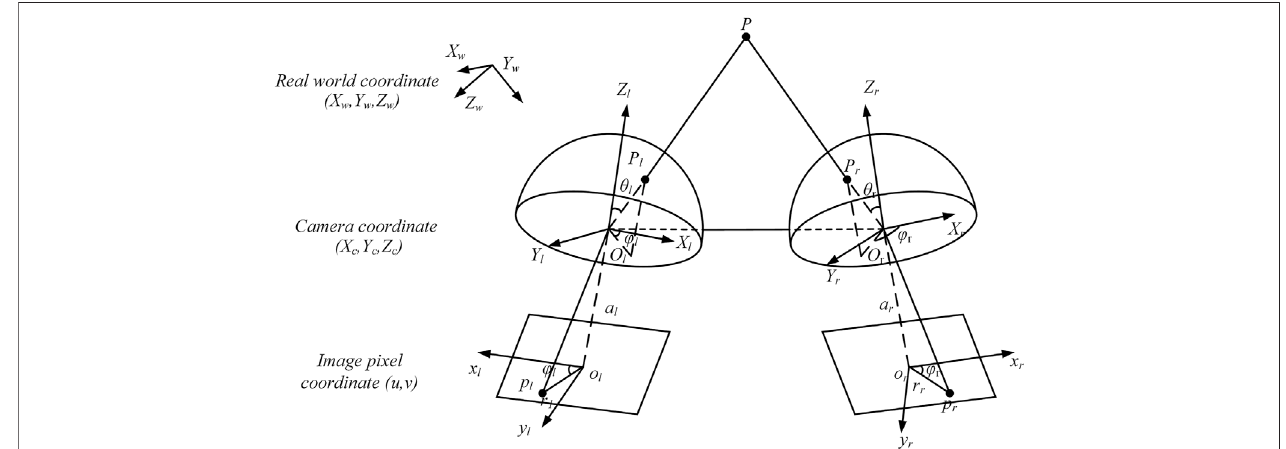
FIGURE 1 | Stereo calibration model of the binocular fi sheye camera.